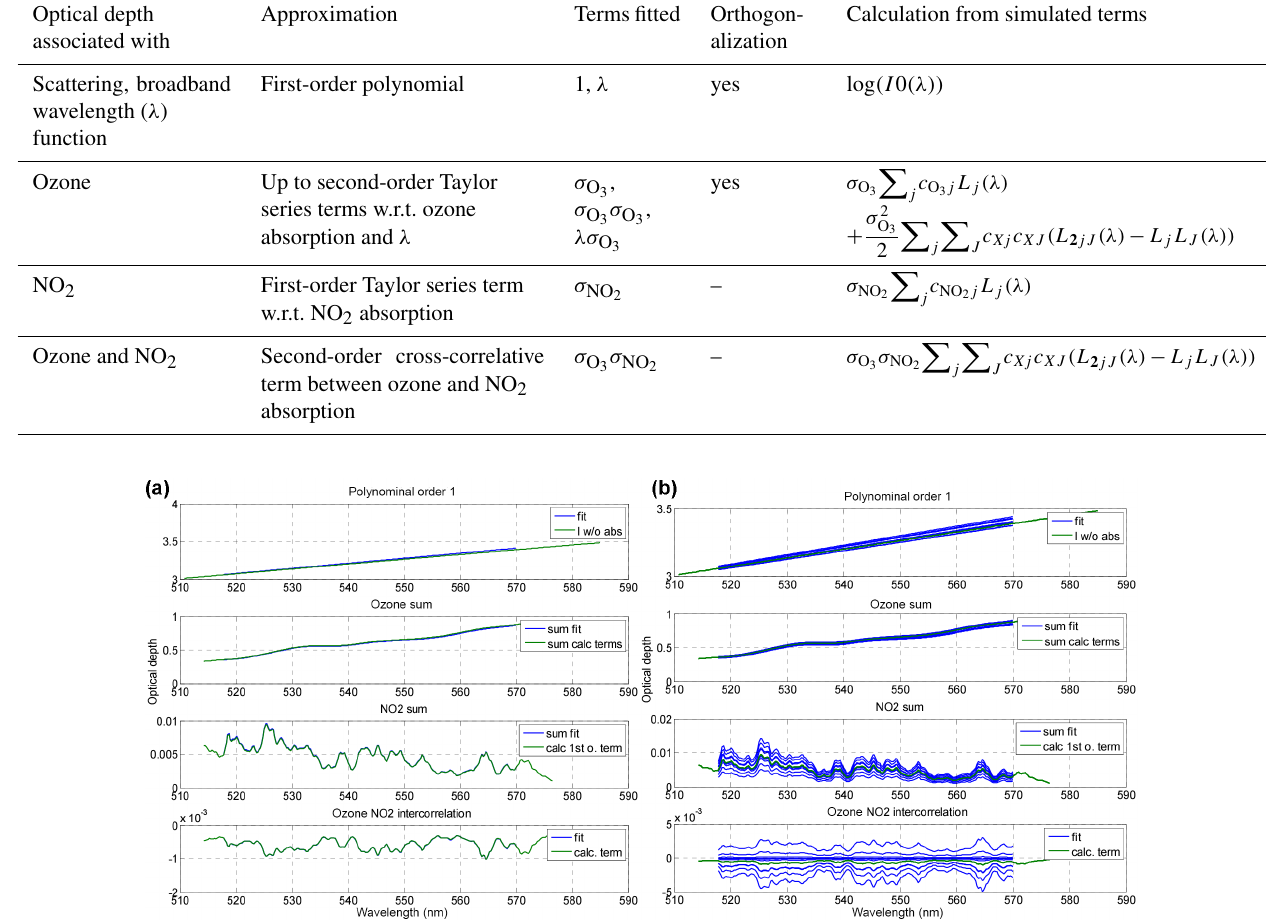
stratosphere. The fit parameters are listed in Table 1. To im- prove the condition of the forward model matrix, the